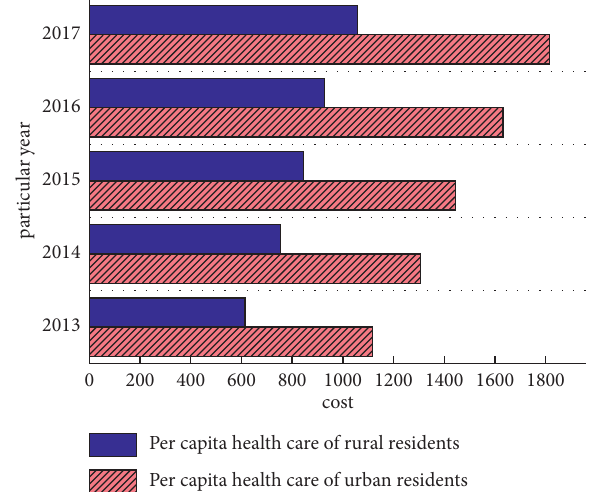
Figure 3: Per capita consumption expenditure of medical care in rural and urban areas.